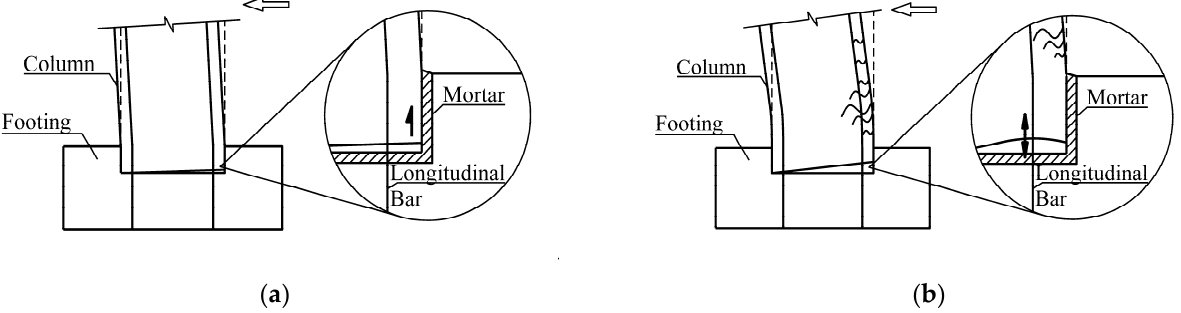
Figure 16. Schematic diagram about deformation in the precast pier with recess: ( a ) Initial state; ( b ) Severely cracked.